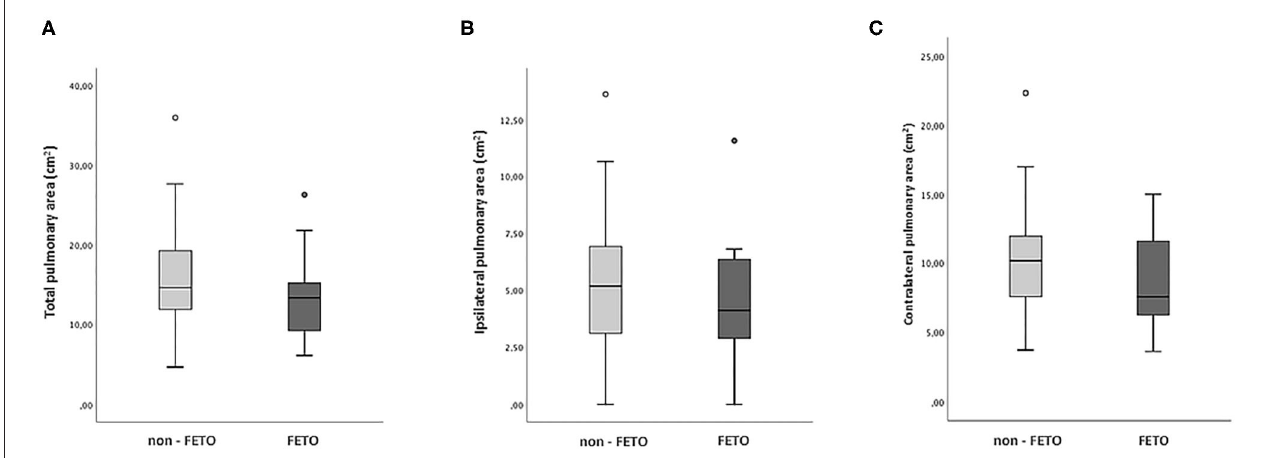
FIGURE 5 | Pulmonary Area in FETO and non-FETO groups. Boxplot showing the distribution of the radiographic measurements in FETO ( n = 11) and non-FETO ( n = 32) patients. Student’s T -Test was performed to compare the two groups. (A) total pulmonary area (cm 2 ), p = 0.358; (B) ipsilateral pulmonary area (cm 2 ), p =